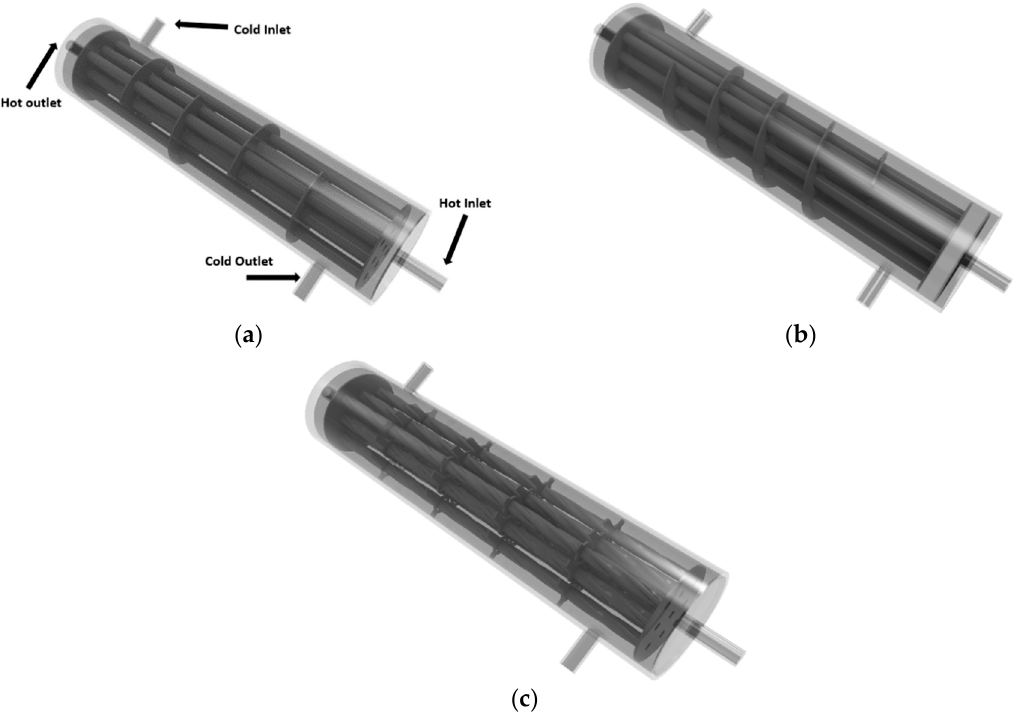
Figure 2. Isometric view of the computational domains for STHXs with: ( a ) segmental baffles; ( b ) helical baffles; and ( c ) clamping antivibration baffles.